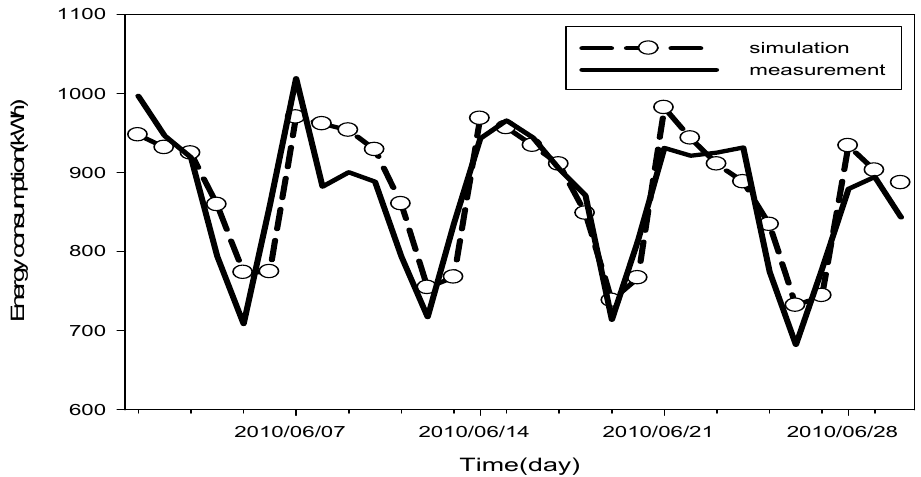
Figure 5. Verification of energy modeling with field measurement data.